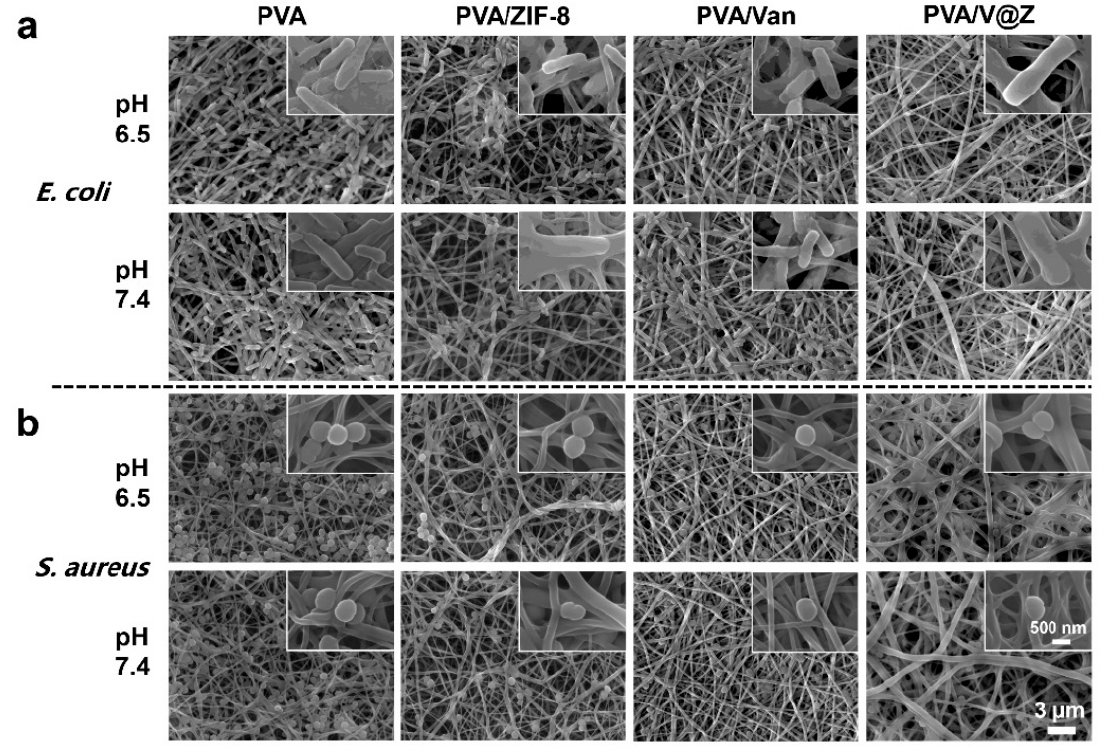
Figure 4. SEM images of different membranes after 12 h co-culture with E. coli ( a ) and S. aureus ( b ) at pH 6.5 and pH 7.4.